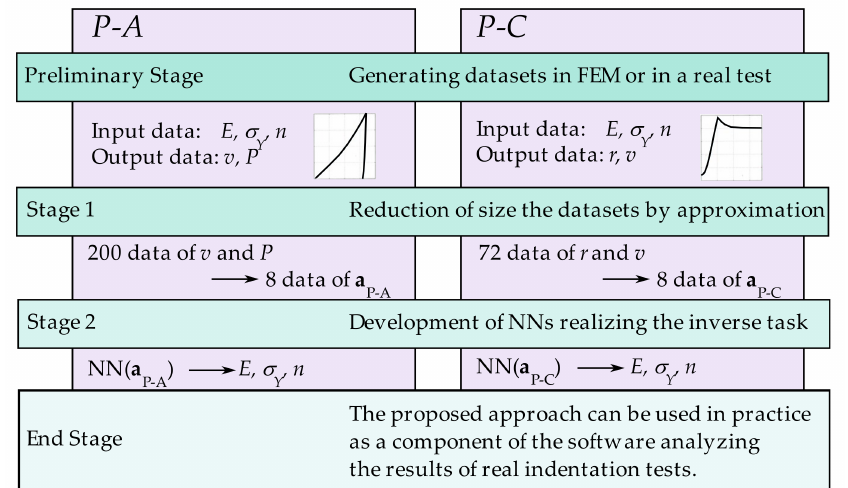
Figure 5. Algorithm of the applied procedure of identifying the material parameters. Stage 1: The imprint indentation curves (Figure 6) and profile curves (Figure 7)